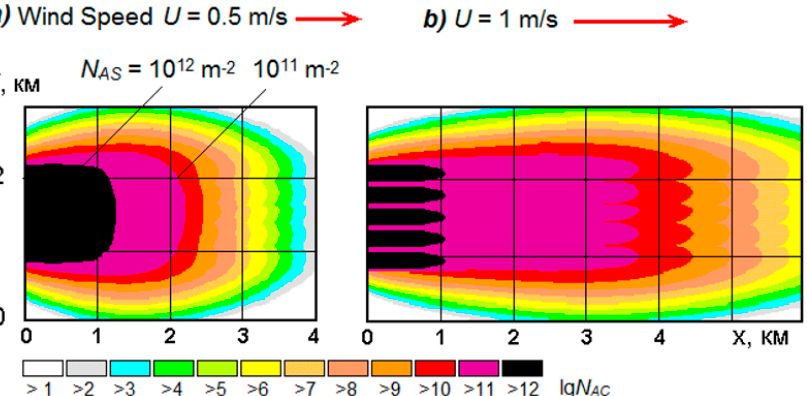
Figure 2. Field of aerosol concentration per unit area ( N AS , m − 2 ) produced by continuous operation for 1 h of 5 sources placed across the wind and consuming 150 kg/h of smoke composition at wind speed: ( a ) u = 0.5 m/s; ( b ) u = 1 m/s.